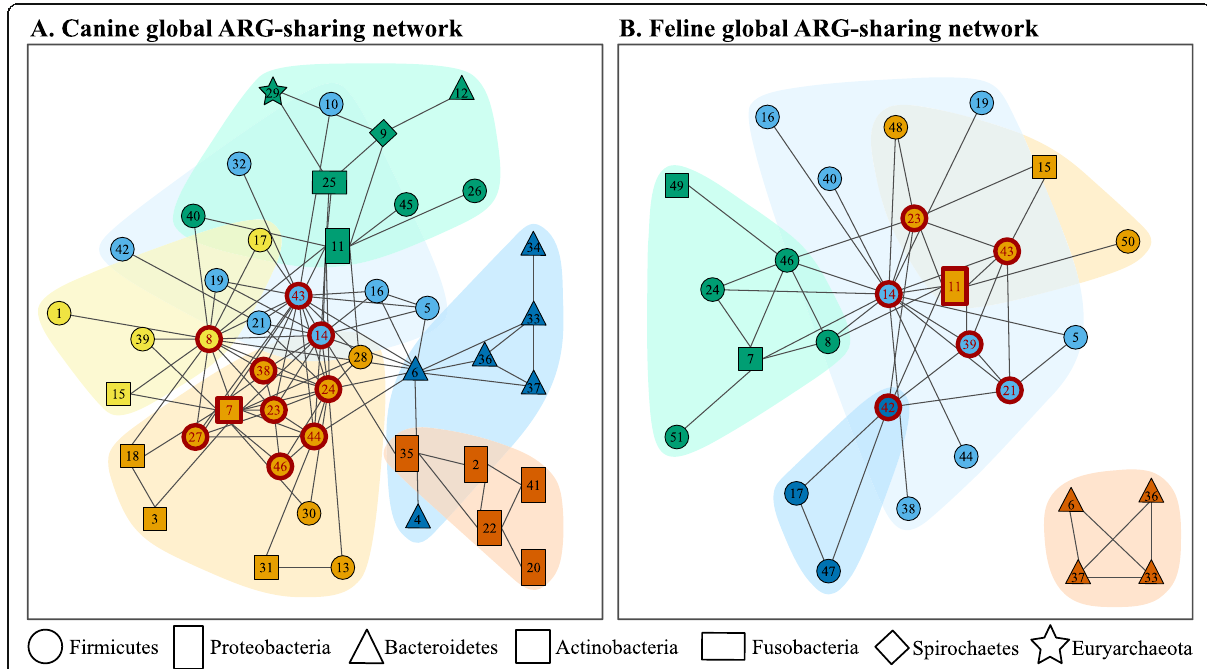
Fig. 5 The global ARG-sharing network of the canine ( a ) and feline ( b ) gut microbiota. Nodes represent genera, with their shapes and colors representing phylum and network community memberships, respectively. Nodes with the same shape represent genera from the same phylum. Nodes with the same color represent genera classified into the same network community, based on the network structure; bacterial genera in the same network community shared ARGs more frequently among themselves than with genera belonging to other network communities. Two genera were connected by an edge if their contigs shared ≥ 1 ARG in ≥ 1 sample. Genera were classified as central (red border and label) and